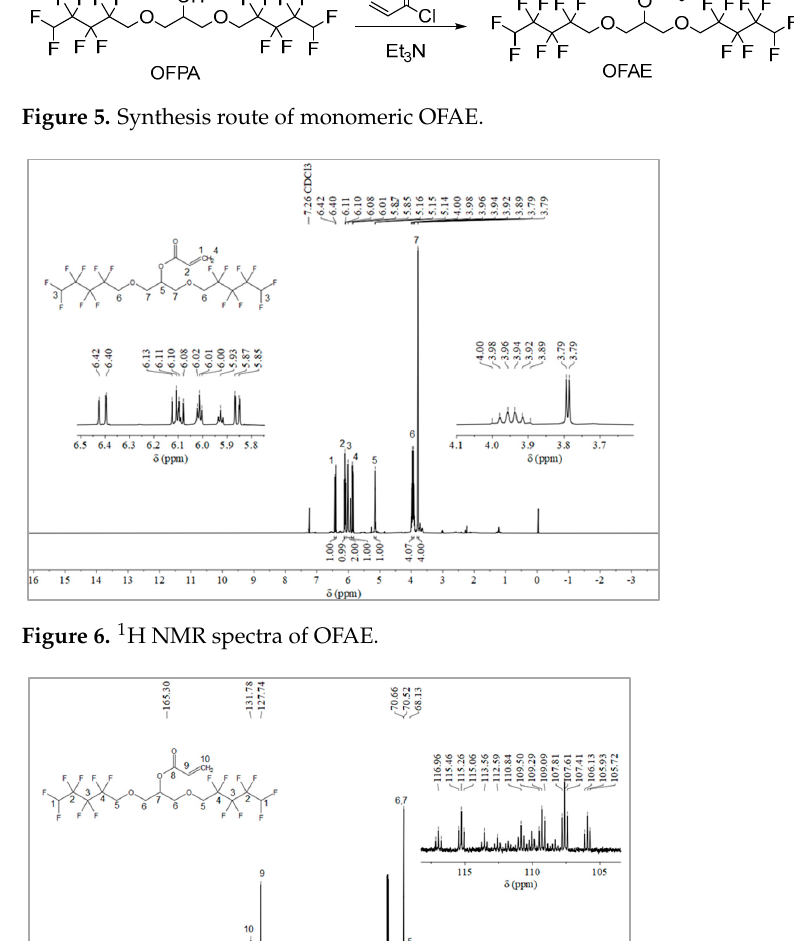
Figure 7. 13 C NMR spectra of OFAE.